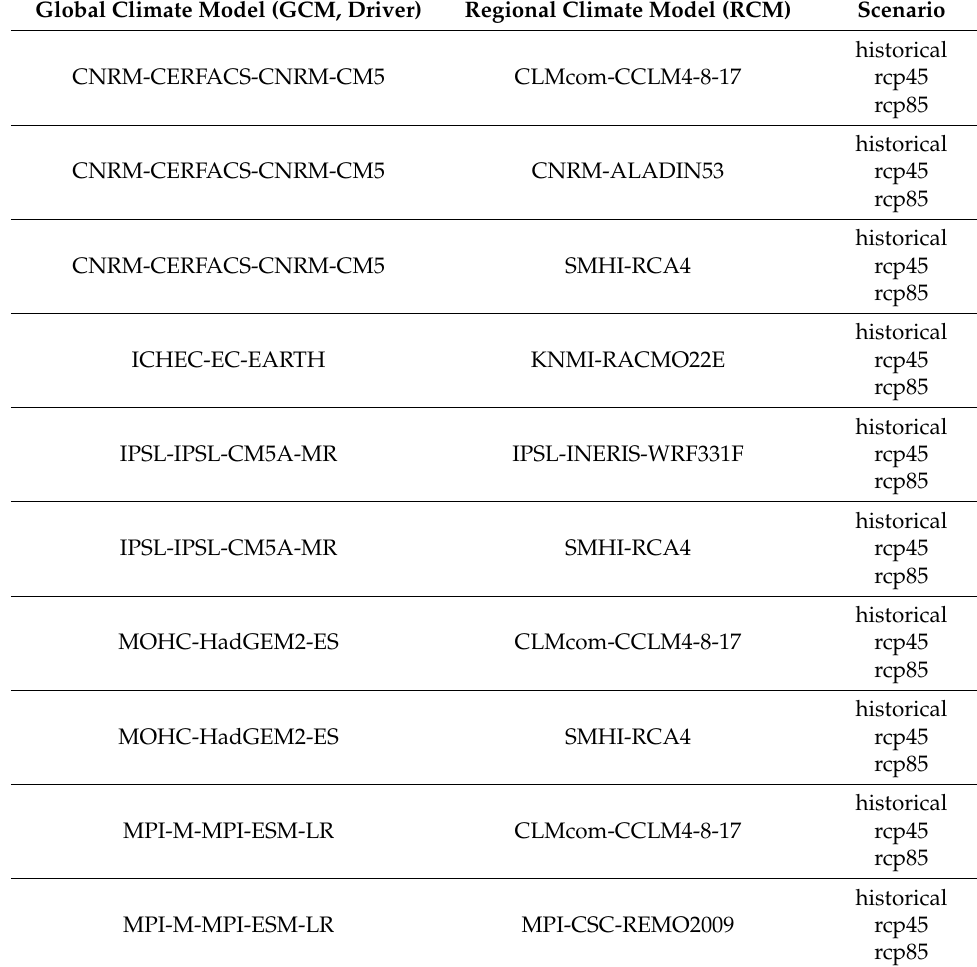
Table 2. Summary of Global Climate/Regional Climate Model chains (GCM/RCM) used in this study over the 2041–2065 (future period 1: FP1) and 2071–2095 (future period 2: FP2) future periods. Global Climate Model (GCM,